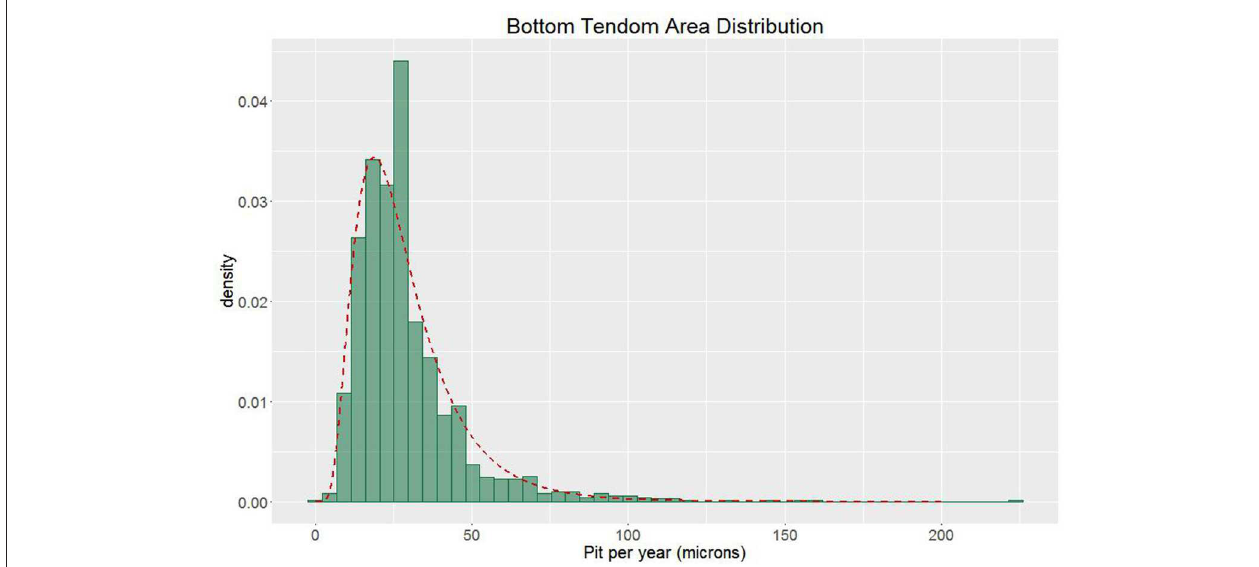
FIGURE 8 | Corrosion depth distribution at bottom tendon area (section C).